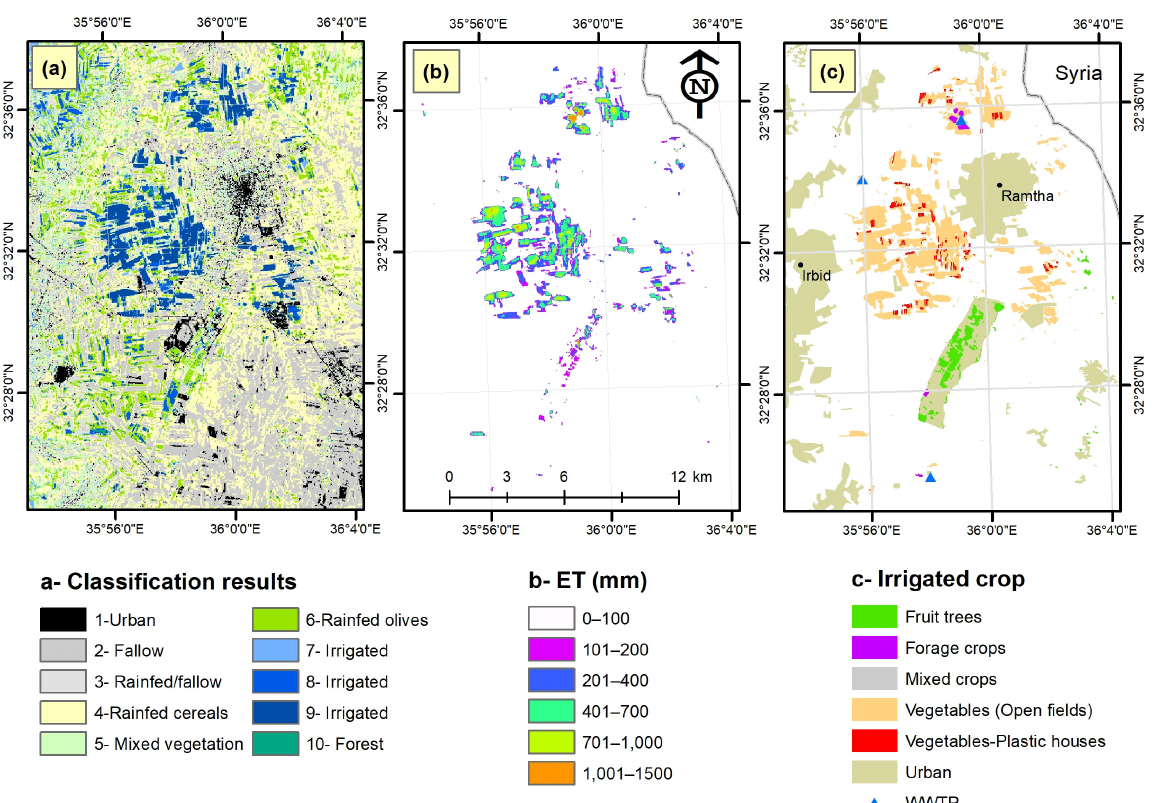
Figure 6. An example of mapping irrigated crops in the Mediterranean highlands for the area of Irbid-Ramtha. ( a ) Results of the unsupervised classification of the multi-temporal NDVI images for the period March-October; ( b ) SEBAL-ET map for March-October; ( c ) Map of irrigated crops after merging digital classification with SEBAL-ET.